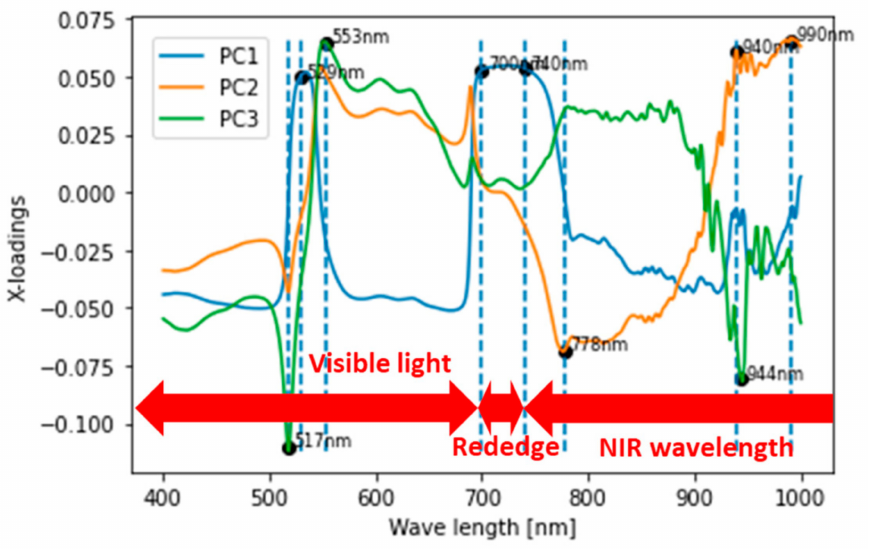
Figure 8. X-loadings analysis of Principal Component Analysis (PCA). X-axis represents wavelength of feature (Unit: nm) while Y-axis represents X-loading values of Principal Components.